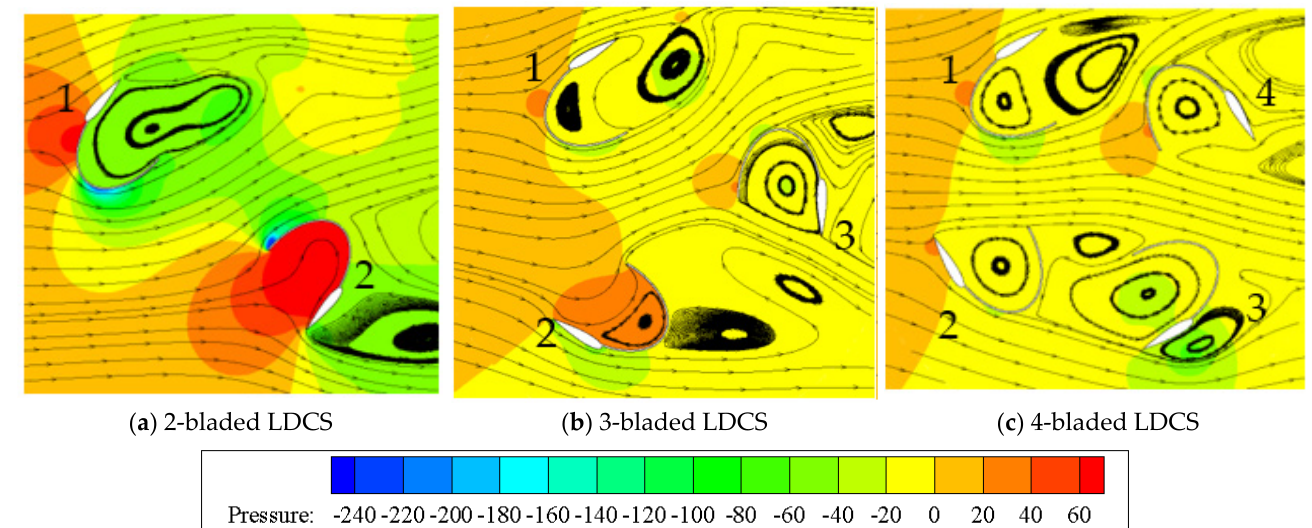
Figure 24. Static flow fields of three number of bladed LDCS ( θ = 30 °): ( a ) 2-bladed LDCS; ( b ) 3-bladed LDCS; ( c ) 4-bladed LDCS.